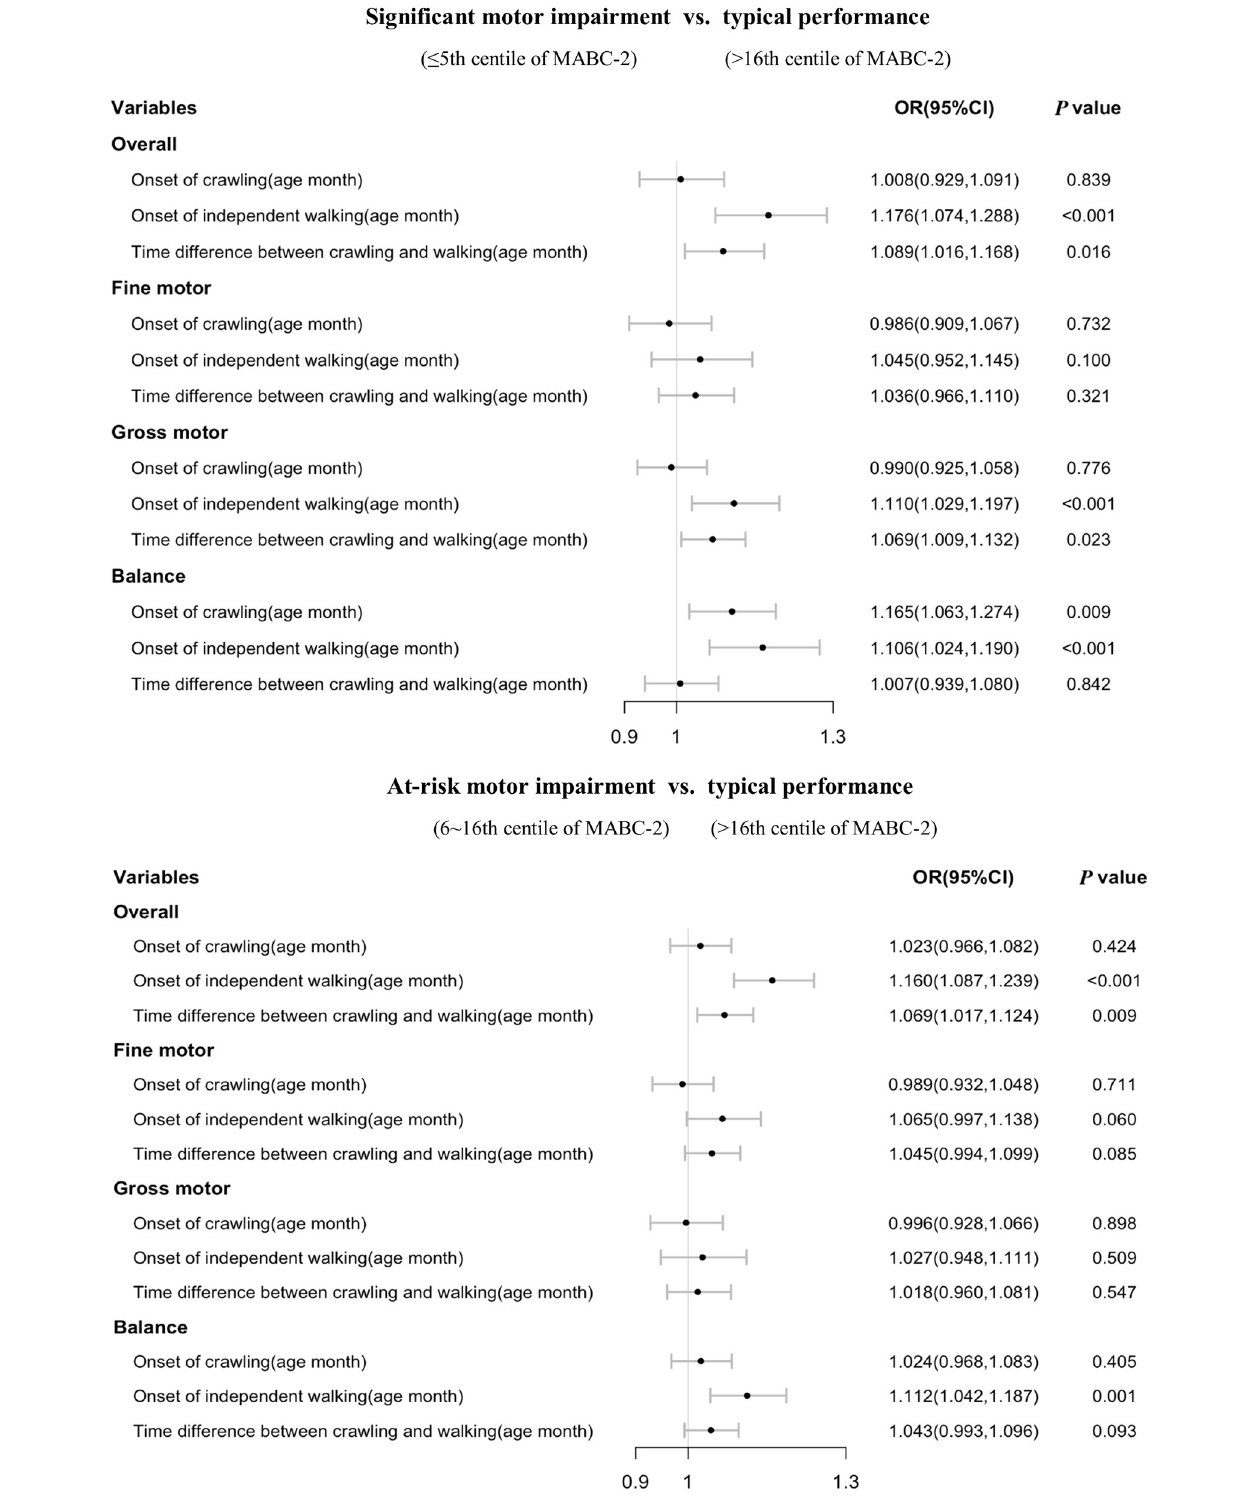
FIGURE 2 | Association of walking and crawling during infancy with motor impairments by different age group in children aged 3–4 years old ( n = 3,469).